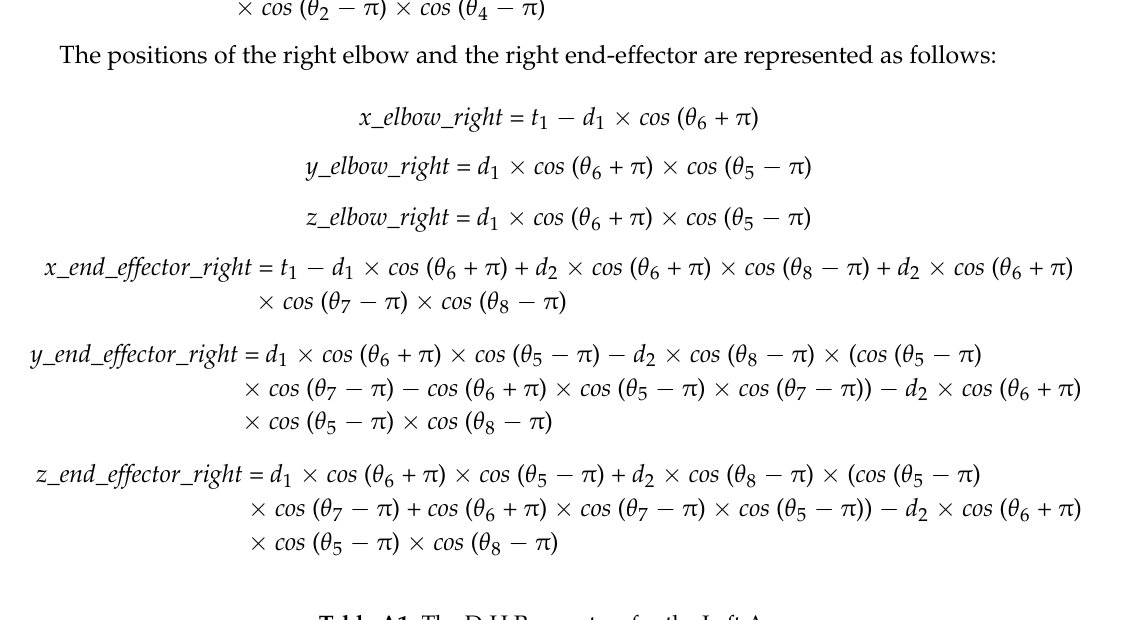
Table A1. The D-H Parameters for the Left Arm.